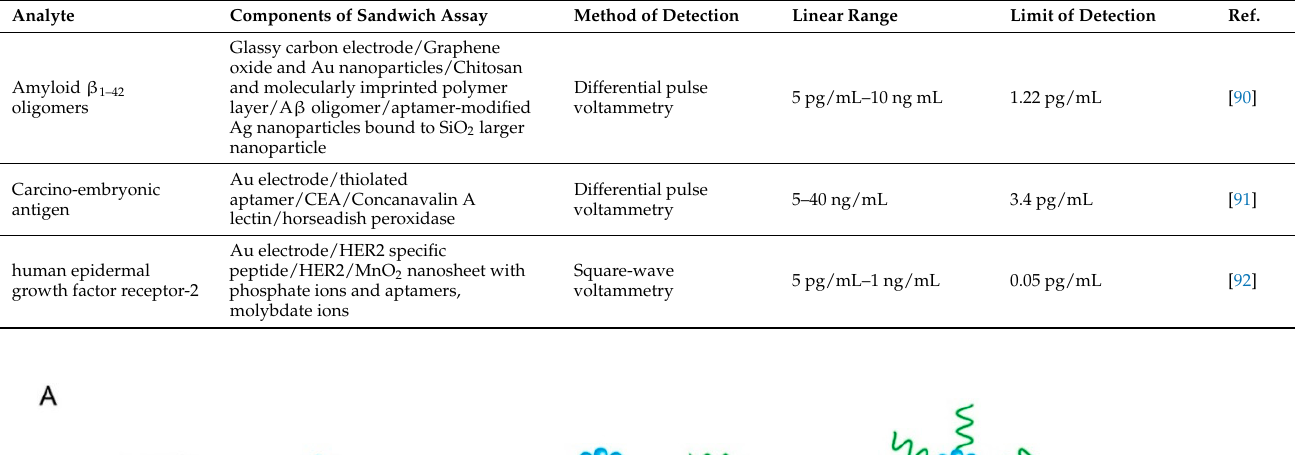
Table 4. Electrochemical Sandwich Assays Combining Aptamers and Lectins or Other Materials.